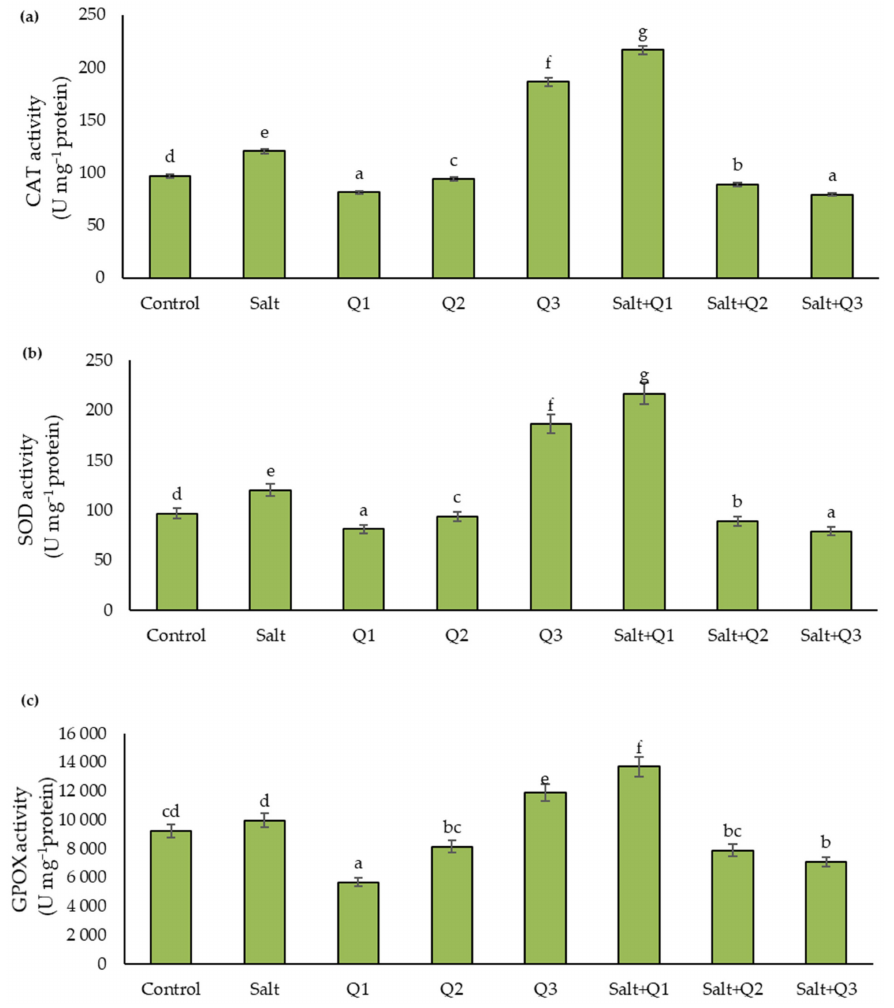
Figure 5. Effect of quercetin–copper complex (Q-Cu (II)) concentrations and salt stress on ( a ) catalase (CAT), ( b ) superoxide dismutase (SOD), and ( c ) guaiacol peroxidase (GPOX) activity. Different letters indicate significant differences between each variant of the experiment, according to ANOVA (followed by Tukey’s HSD test, p = 0.05). Table 1. Regression equations for physiological and biochemical processes in wheat